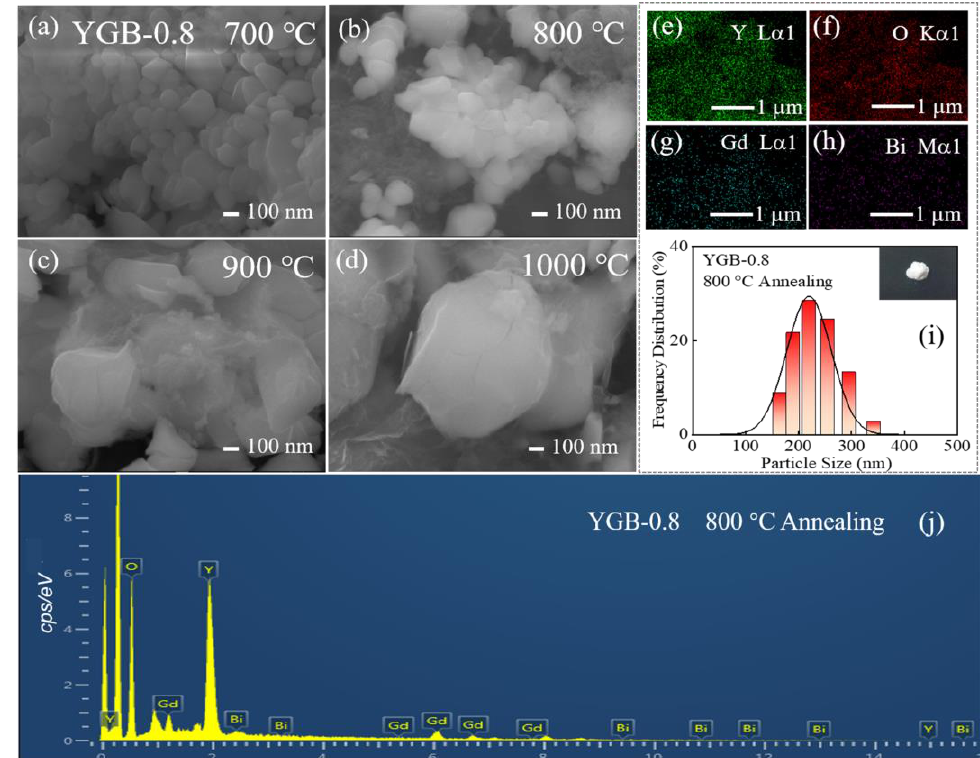
Figure 4. ( a – d ) SEM images of YGB-0.8 samples with different annealing temperatures ranging from 700 °C to 1000 °C. ( e – h ) Elemental mapping; ( i ) particle size distributions and ( j ) EDS spectrum of the YGB-0.8 sample annealed at 800 °C. Inset in ( i ): the macroscopic appearance of the sample exhibited under natural light irradiation.